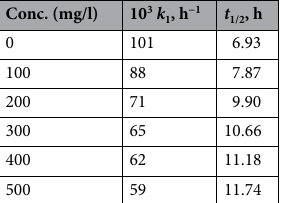
Table 2. Values of the first-order rate constant ( k 1 ) and half-life ( t 1/2 ) of copper corrosion in 1.0 M H 2 SO 4 solution and in the presence of the surfactant HS at 298 K.